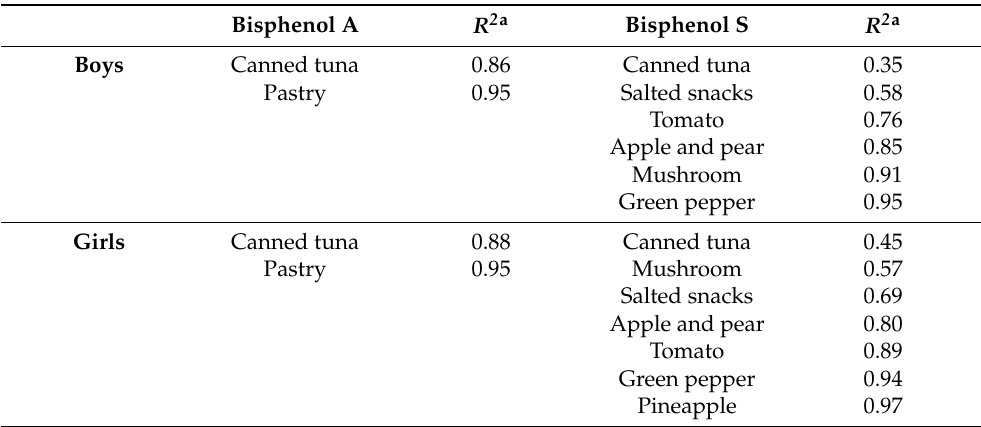
Table 3. Food products that contribute to more than 95% of dietary bisphenol exposure according to gender (stepwise regression).